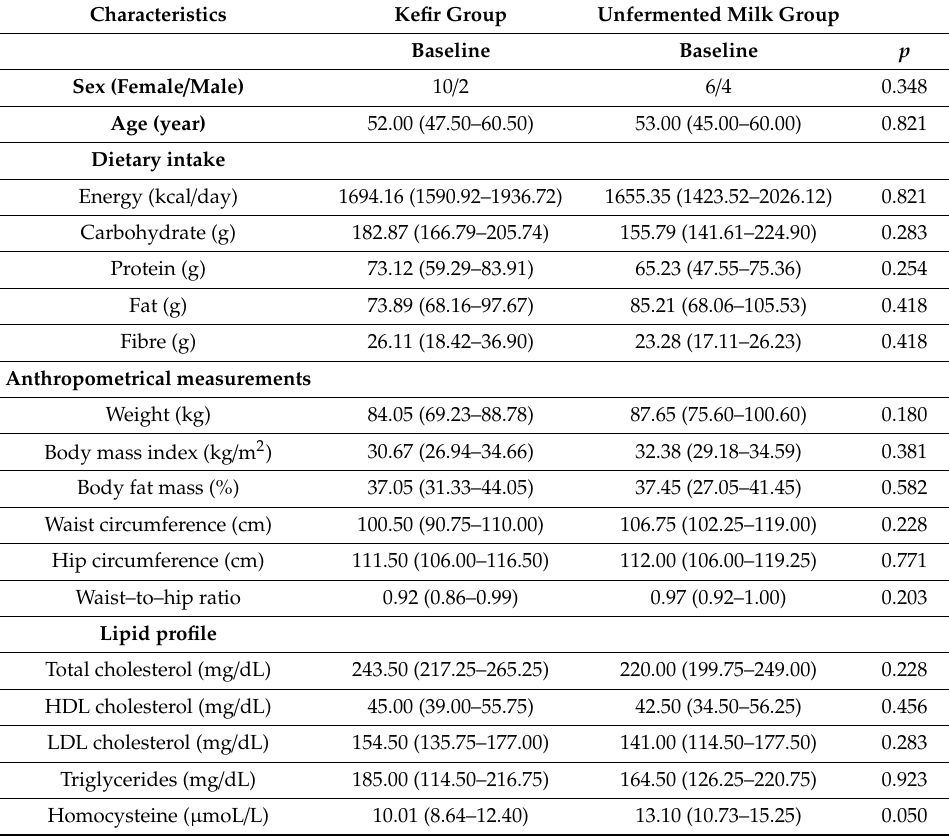
Table 1. Baseline characteristics of kefir and unfermented milk